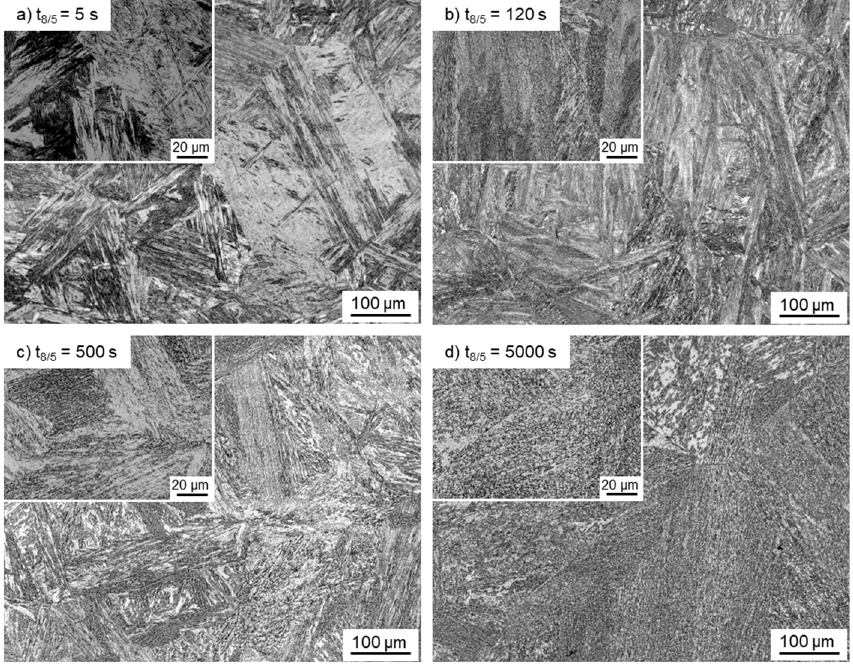
Figure 14. OM images of the microstructure of the dilatometer specimens from the base metal CCT diagram which were heated to 1200 °C for 5 min and cooled with different cooling t 8/5 -times of ( a ) 5 s; ( b ) 120 s; ( c ) 500 s; and ( d ) 5000 s at lower and higher magnifications, respectively.